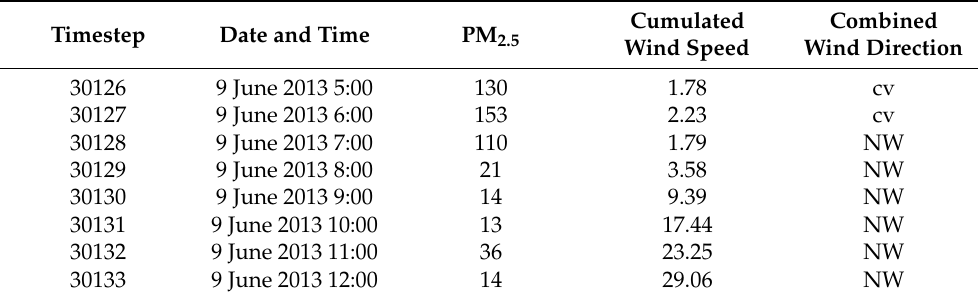
Table 7. An excerpt from Beijing dataset matching the sharp transition in results (cv = calm and variable, NW =